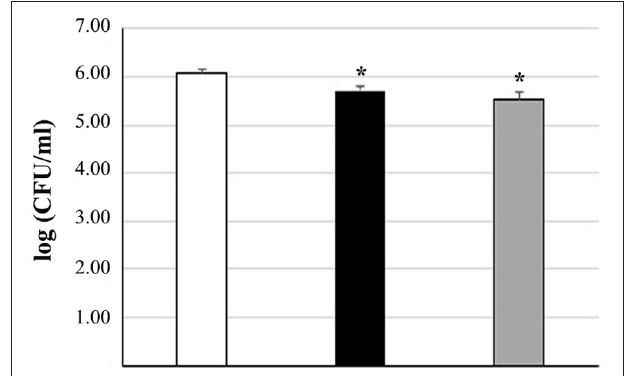
FIGURE 5 | Reduction of Salmonella enterica adhesion to Caco-2 cells by L. pentosus D303.36 and L. coryniformis H307.6. Cell counts of viable S. enterica serovar Thyphimurium LT2 adhering on differentiated Caco-2 cells treated with: S. enterica alone (control, white column); S. enterica in combination with L. pentosus D303.36 (black column) or L. coryniformis H307.6 (gray column). Columns represent the mean ± SD of four independent experiments. Data are reported as log of bacterial CFU recovered after plating. Statistical analysis was performed by one-way ANOVA, followed by post-hoc Tukey honestly significant difference (HSD) test. Asterisks indicate significant differences (* p < 0.05 vs. control).